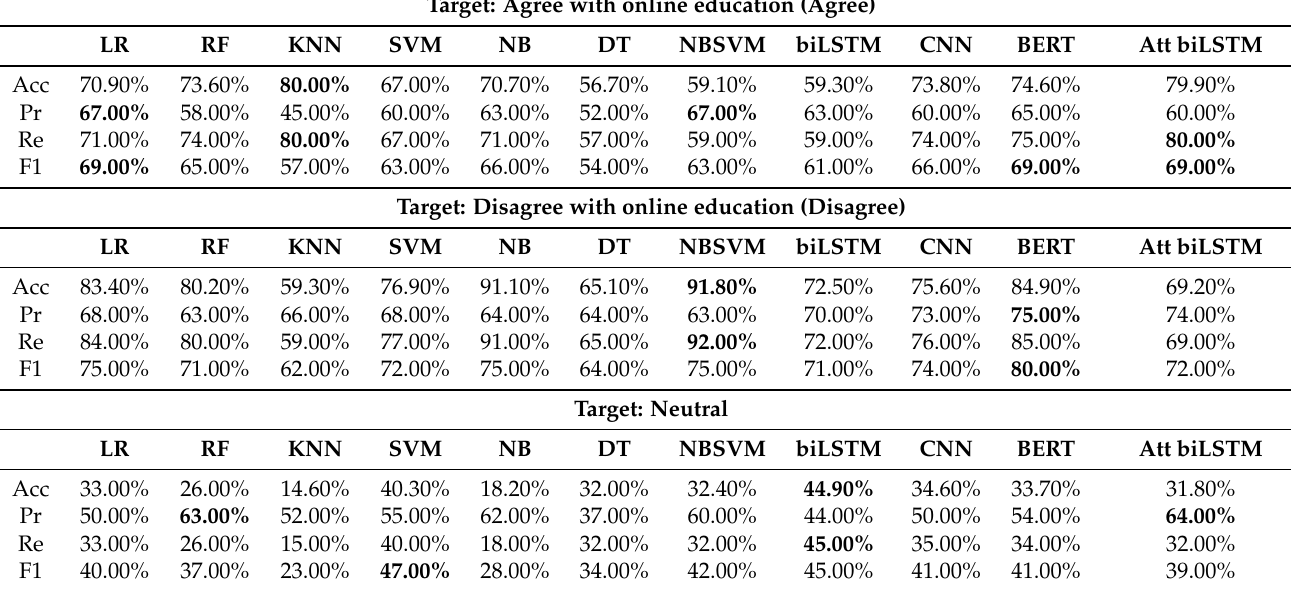
Table 5. Performance of the traditional and deep learning models on every class using the StEduCov dataset. Average weighted values of Pr: precision, Re: recall, F1 Score and Acc: Accuracy. Bold values indicate the highest